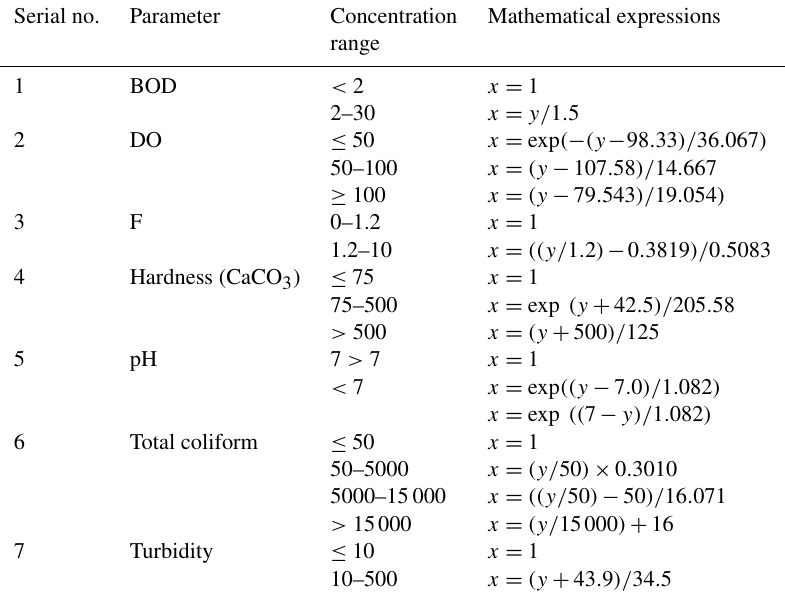
Table 2. Mathematical expressions for value function curves (source: Sargoankar and Deshpande, 2003). Serial no. Parameter Concentration Mathematical range